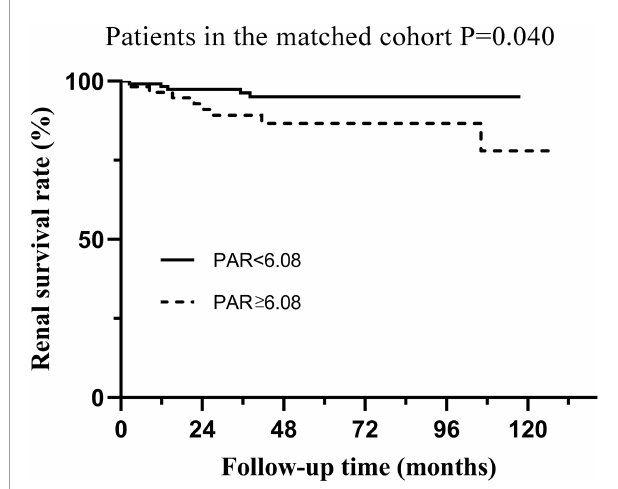
FIGURE 3 | Kaplan-Meier analysis for the endpoint of ESRD in the matched cohort which was divided by PAR.